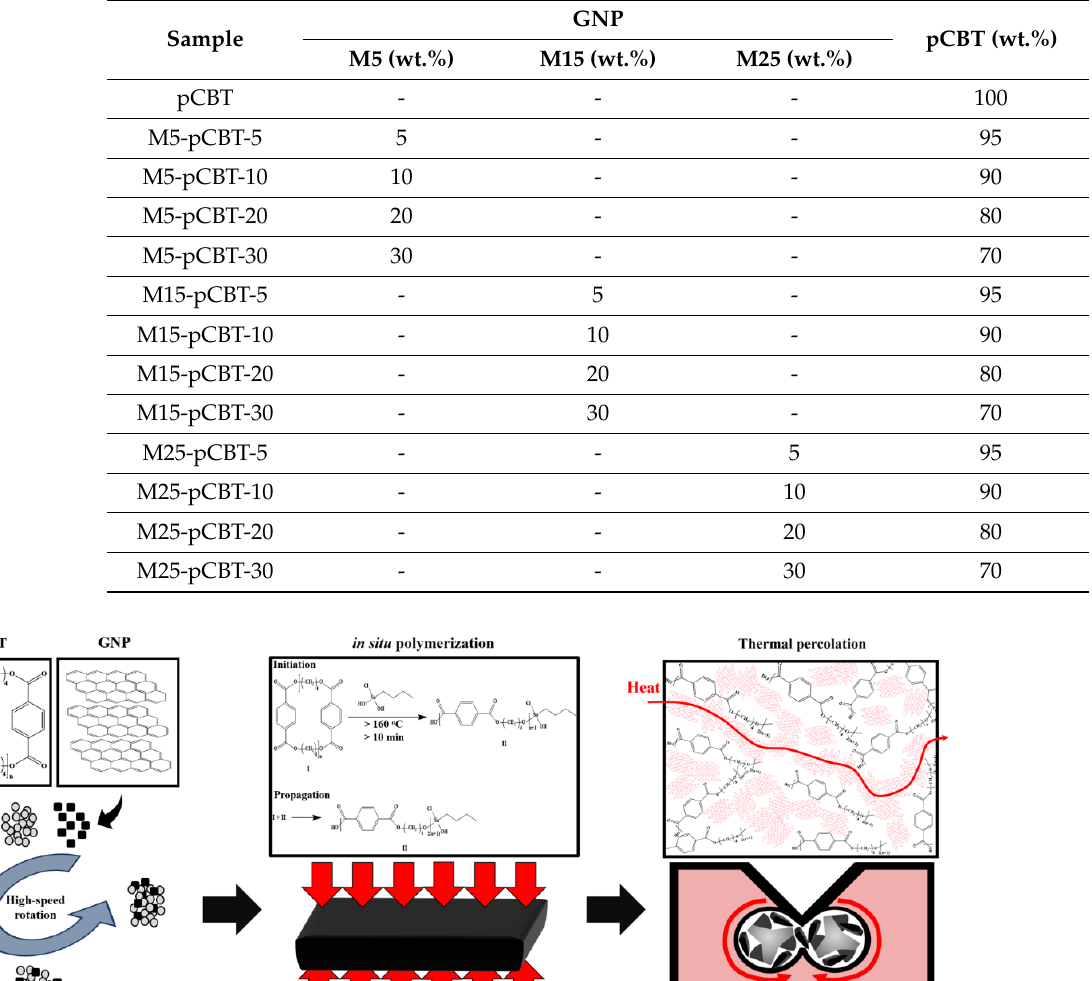
Table 1. Compositions of the fabricated composites.